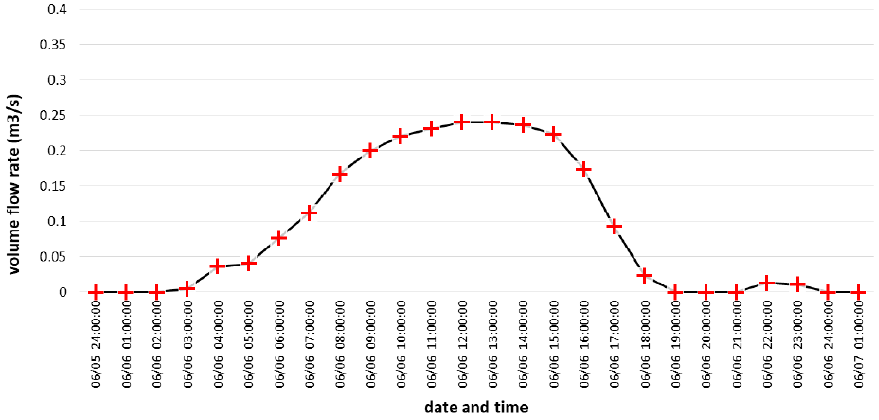
Figure 11. Simulated course of volume flow rate through the upper opening from the attic to the outside. Table 5. Airflow characteristics through the openings at 6:00 p.m. obtained from BPS simulation.